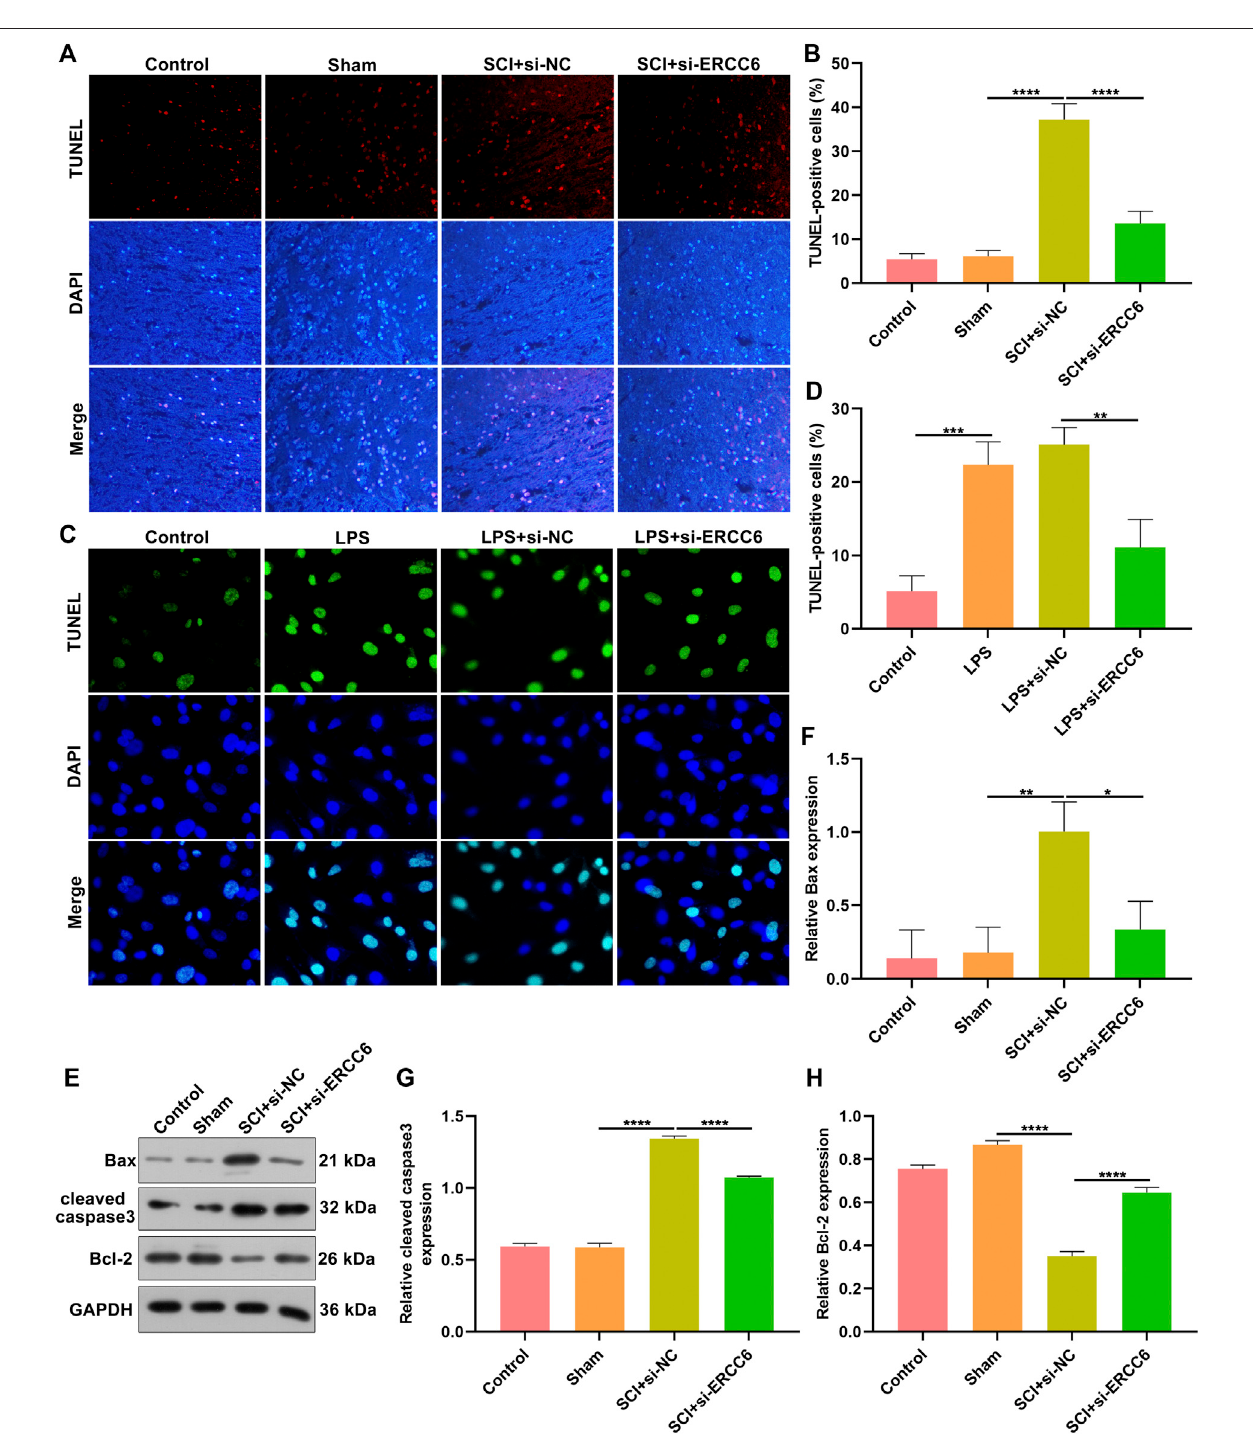
FIGURE 3 | ERCC6 knockdown decreases apoptosis in the spinal cord of ICI mice and LPS-induced mouse microglia cells. (A,B) TUNEL staining of apoptotic levels in the damaged spinal cord of mouse models injected with si-ERCC6 or si-NC as well as control and sham operation mice (scale bar, 50 μ m; N = 8 mice in each group). (C,D) TUNELstainingofapoptoticlevelsinLPS-exposedBV2mousemicrogliacellstreatedwithsi-ERCC6orsi-NC(scalebar,50 μ m;N=3miceineachgroup). (E – H) WesternblottinganalysisforBax,cleavedcaspase-3aswellasBcl-2inthespinalcordtissuesofSCImiceinjectedwithsi-ERCC6orsi-NCaswellascontrol and sham operation mice (N = 8 mice in each group). p -values were calculated with ANOVA test. * p -value < 0.05; ** p -value < 0.01; *** p -value < 0.001; **** p -value < 0.0001.